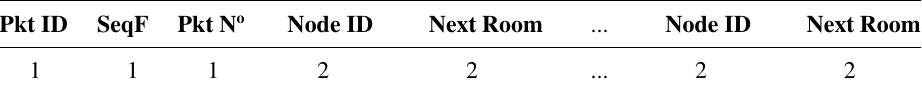
Table 1. GuidingInfo packet. Each column includes the field name and its